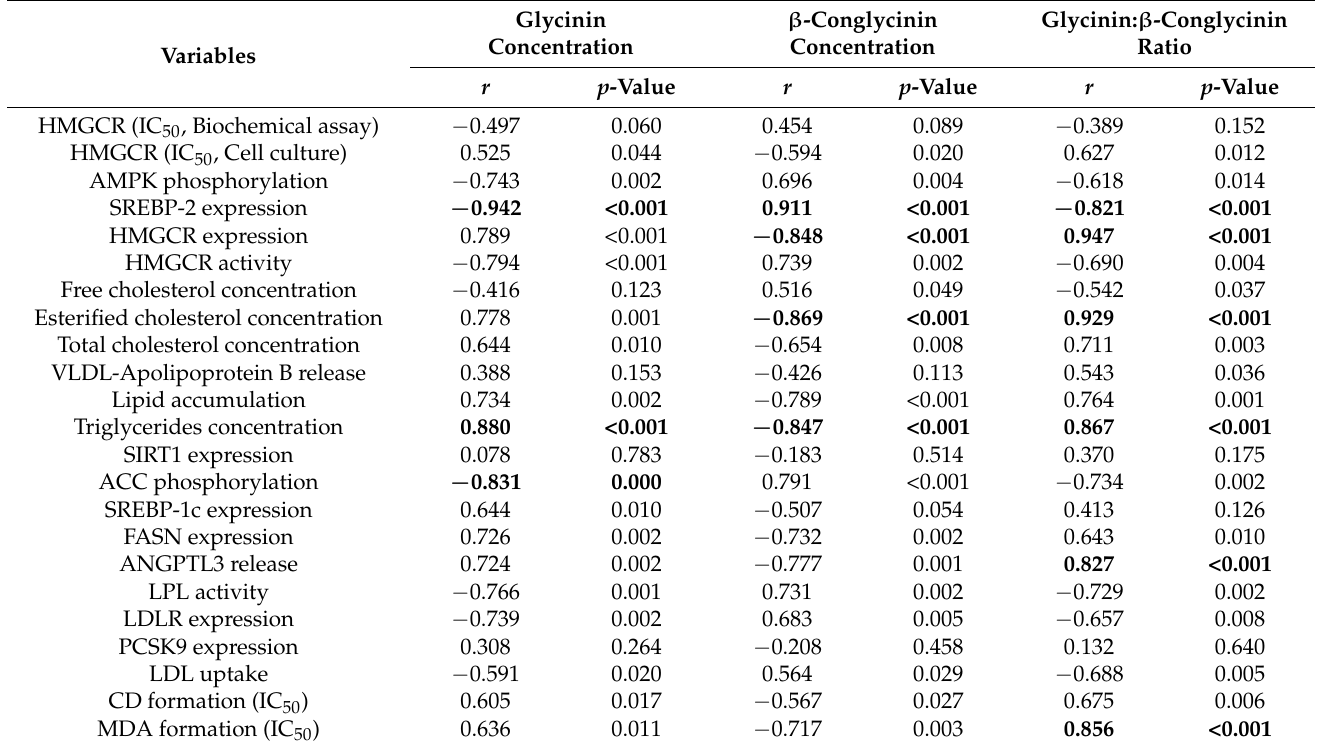
Table A1. Pearson correlations between the concentration of glycinin and β -conglycinin, and the glycinin: β -conglycinin ratio and the evaluated biochemical and cell culture markers of cholesterol metabolism and LDL